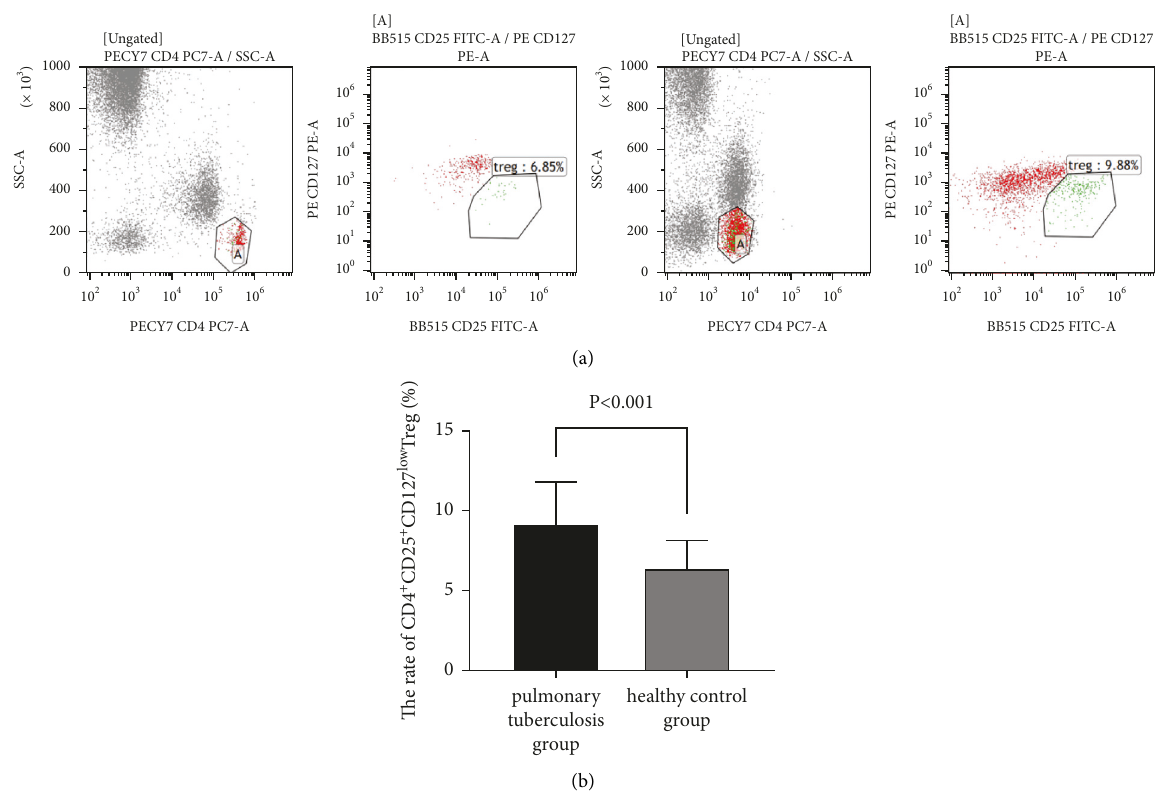
Figure 1: Flow cytometric analysis of CD4 + CD25 + CD127 low Tregs in peripheral blood. Flow cytometry is performed to detect the proportions of CD4 + CD25 + CD127 low Tregs in the peripheral blood samples of patients with active pulmonary tuberculosis and healthy adults. (a) Representative flow cytometric plots for detection of CD4 + CD25 + CD127 low Tregs expression. CD4 + , CD25 + , and CD127 low T lymphocytes were gated. (b) Comparison of proportions of CD4 + CD25 + CD127 low Tregs between active pulmonary tuberculosis patients and healthy